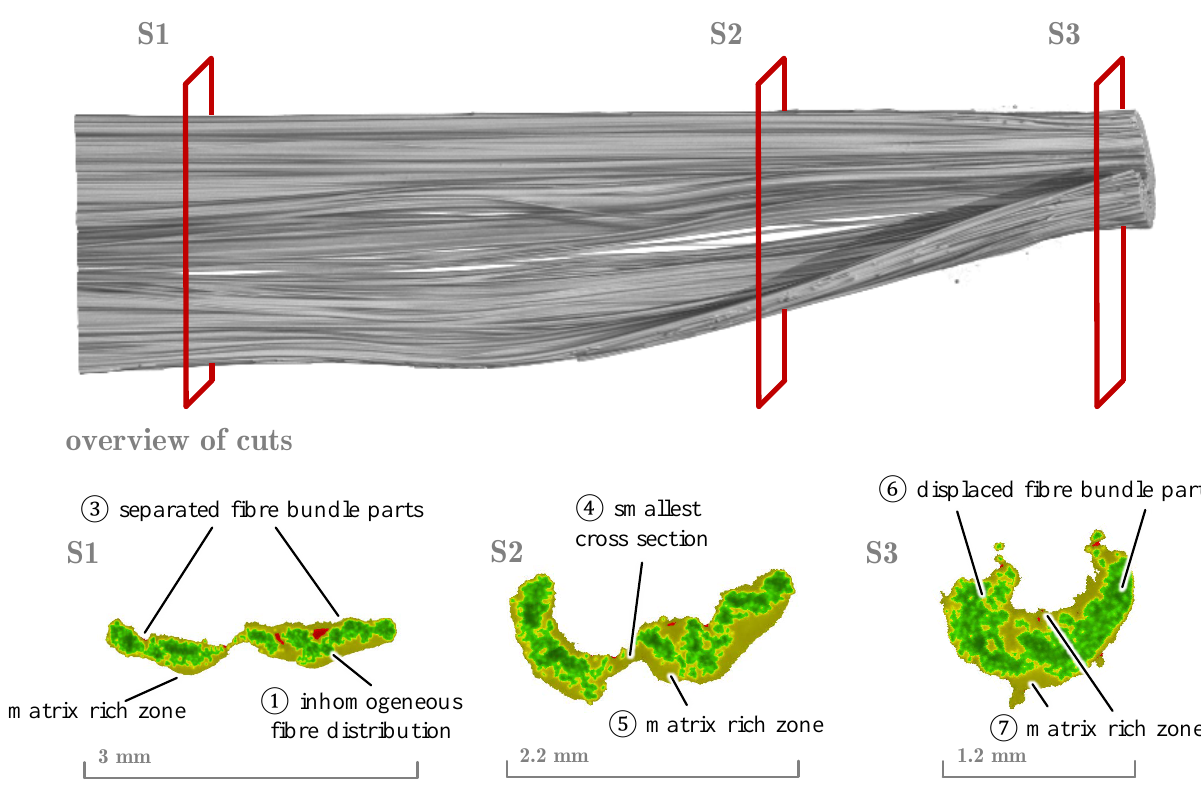
Figure 15. CT reconstruction data and section cuts of deformed GF-PP 30mm/s and 200°C, D fe =